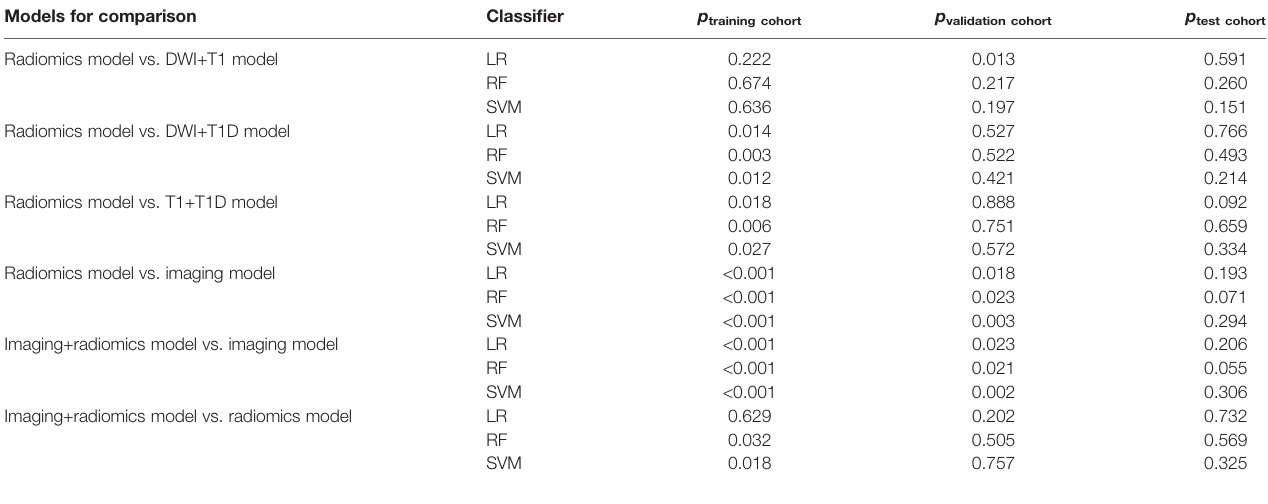
TABLE 4 | The comparison of models in training, validation, and test